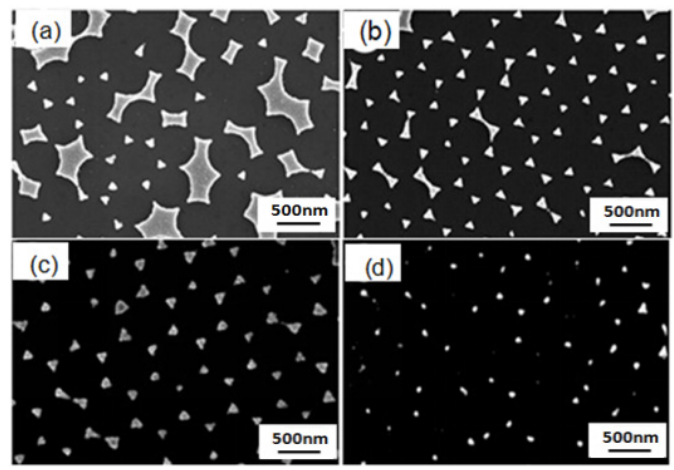
Figure 8. SEM images of two-dimensional ordered Au-Ag nanopariticle arrays as a function of concentration of PS nanospheres in the dipping solution. ( a ) 4 wt %; ( b ) 6 wt %; ( c ) 8 wt %; and ( d ) 10 wt %, respectively.